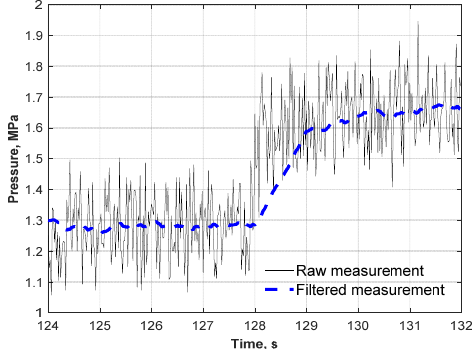
Figure 8. Filtering of pressure signal within the window of 50 specimens for 1000 ms.